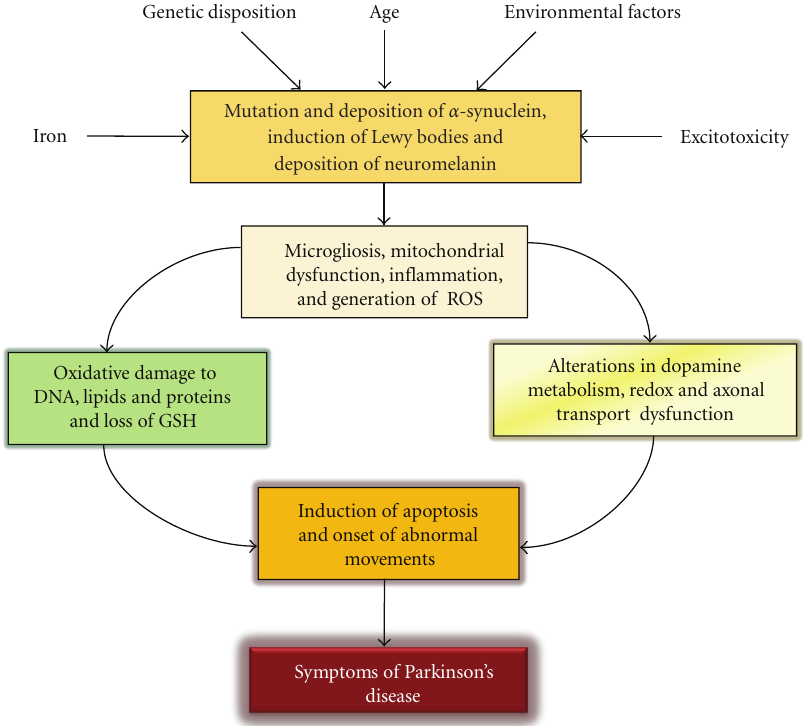
Figure 1: Potential factors and events associated with the pathogenesis of